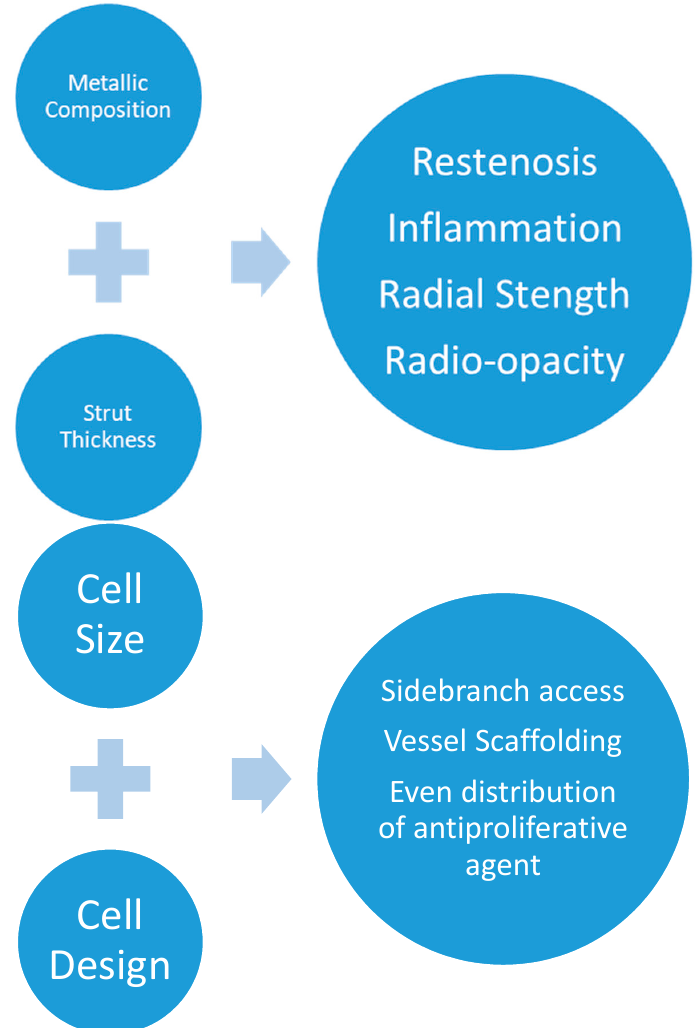
Figure 2. Graphic representation of the clinical correlates of the stent characteristics. Metallic choice influences the strut thickness which in turn affects radial strength, radio-opacity, and inflammation. The cell size and design (open versus closed cell) affects the ability to access the side branches and scaffold the artery, while distributing the antiproliferative agent to the vessel wall.